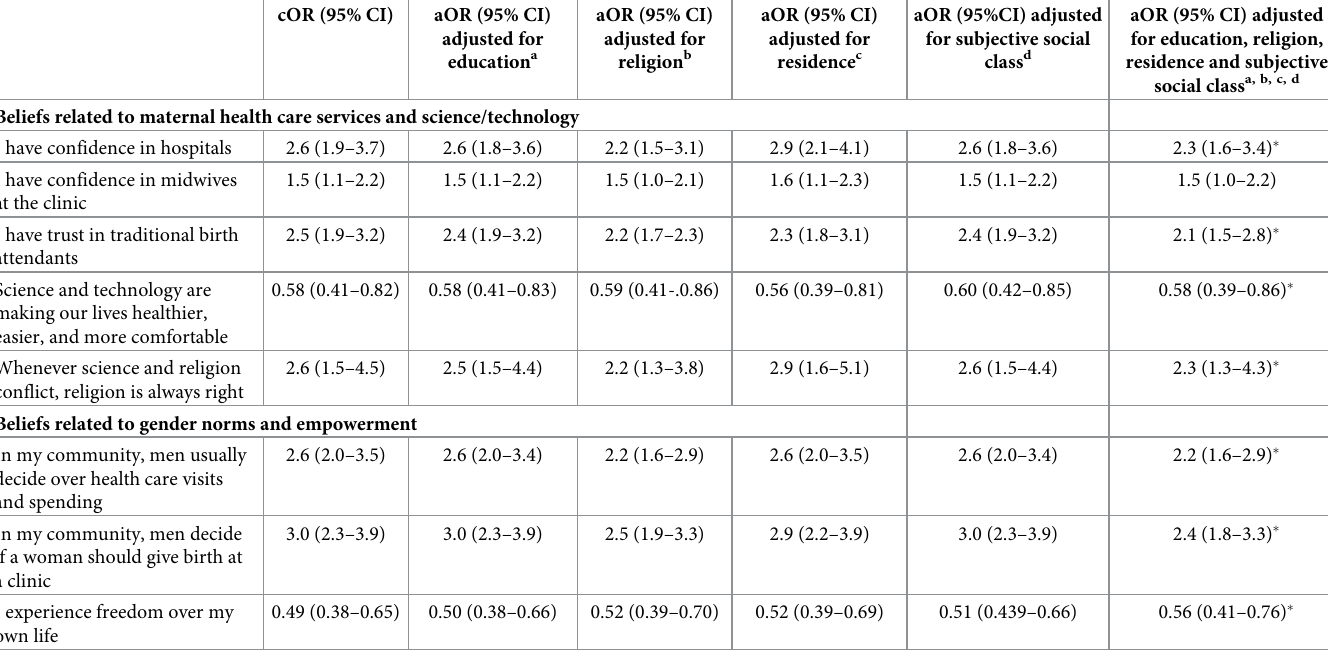
Table 5. Multivariable logistic regression of likelihood of participants in states with low proportions of facility birth agreeing to the